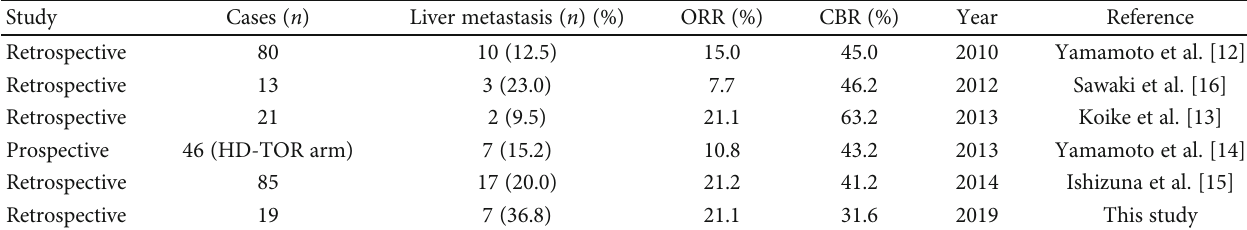
Table 5: Associations between liver metastasis and HD-TOR clinical bene fi t